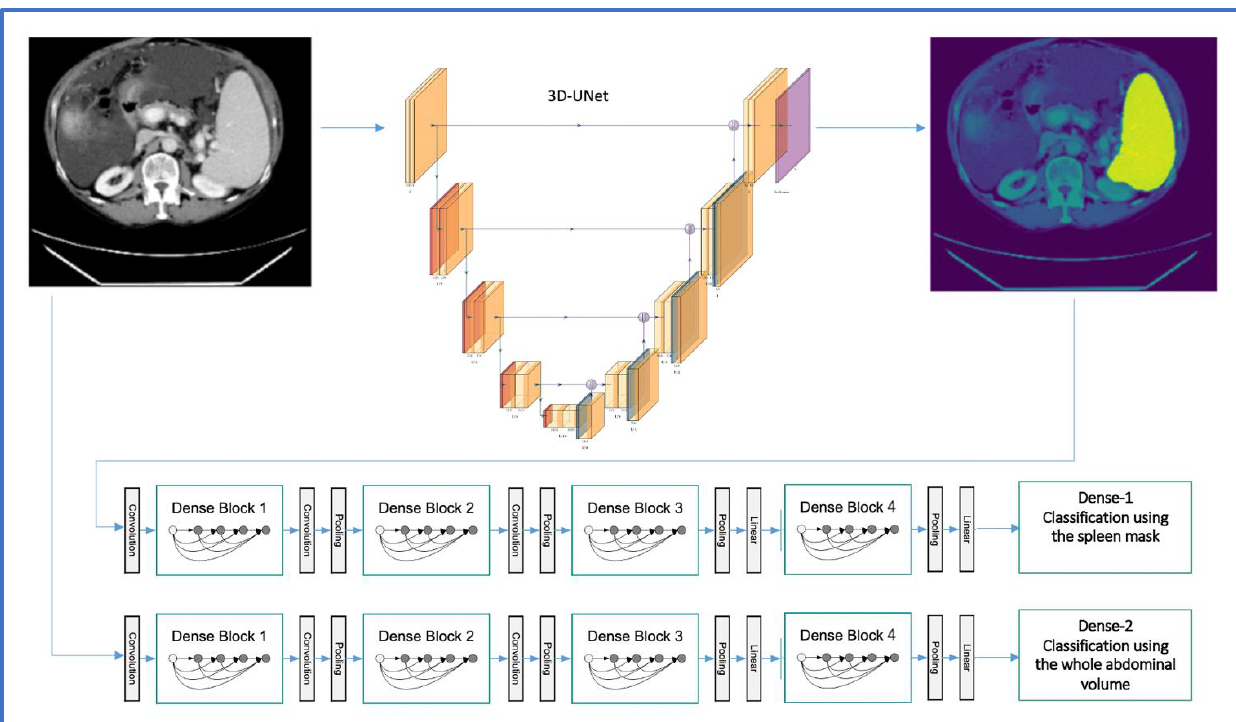
Figure 3. 3D-UNET and DenseNet 121 architectures for the automated segmentation and classification of splenomegaly in the two-step approach (image adapted with permission from PlotNeuralNet [26], Copyright (c) 2018 HarisIqbal88. Available under the MIT license).